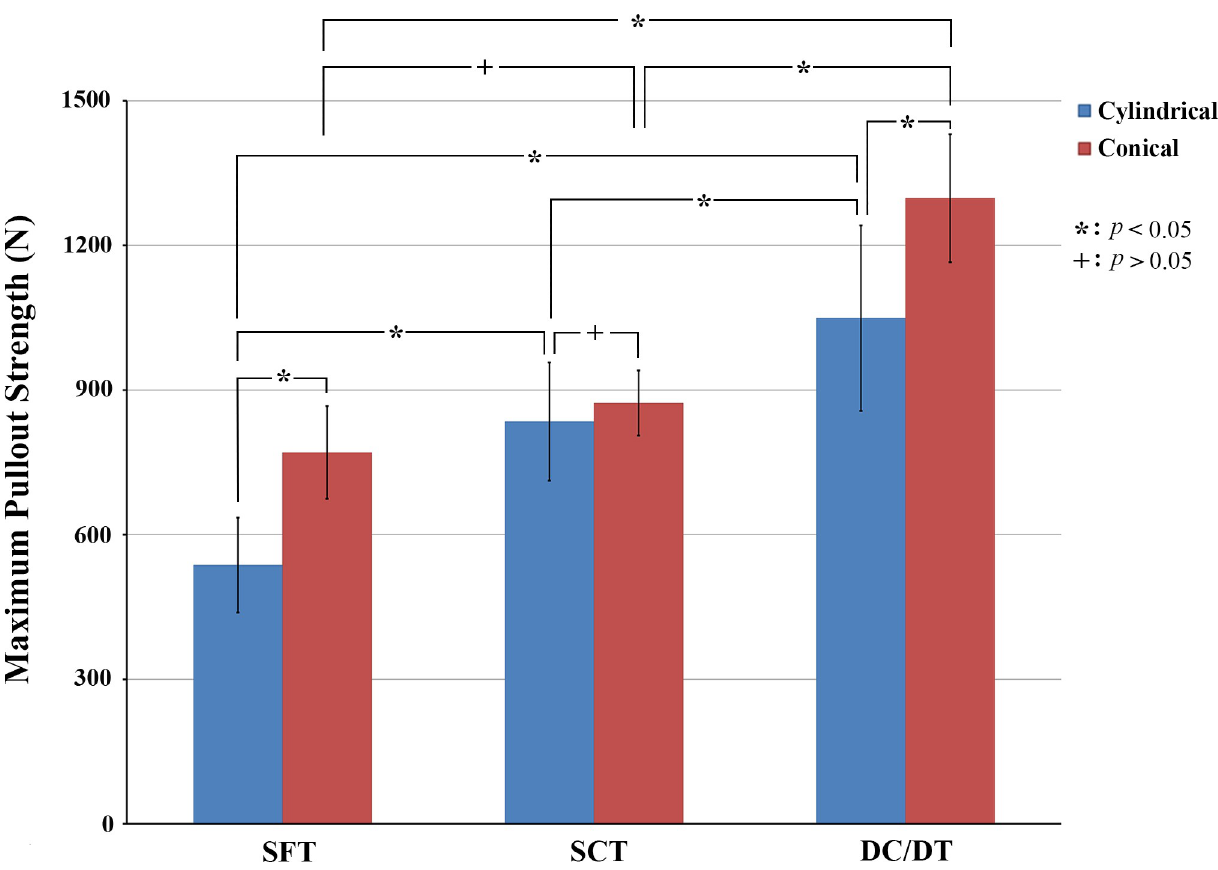
Fig 4. Mean maximal pullout strengths in six groups of synthetic vertebrae instrumented with solid screws. Regardless of the screw outer geometry (conical or cylindrical), solid screws with DC/DT thread profiles exhibited significantly higher pullout strengths than those with SFT or SCT profile.